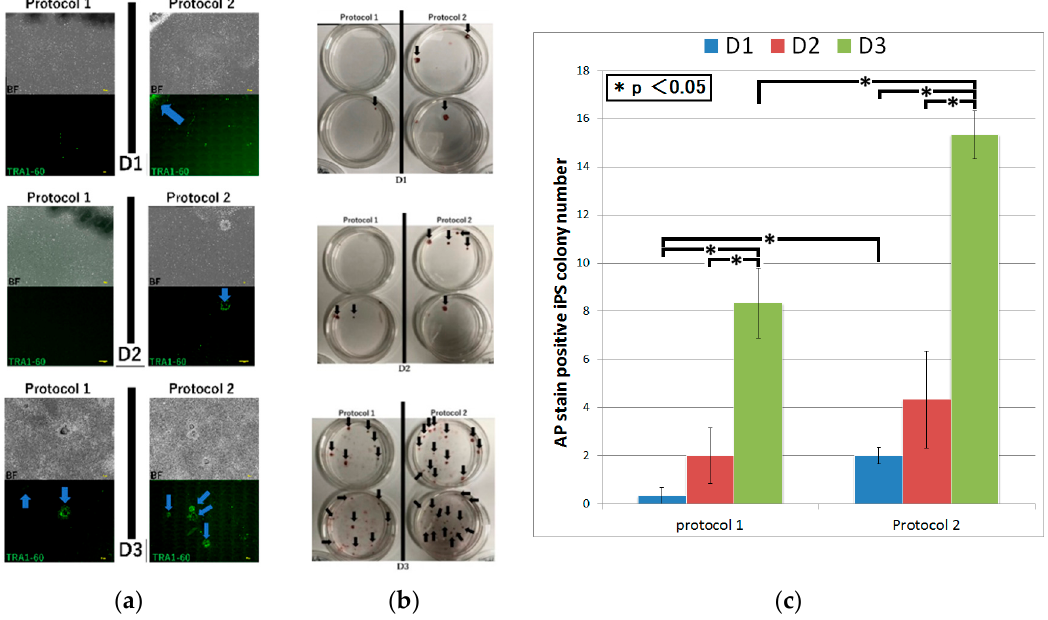
Figure 4. TRA-1-60 and alkaline phosphatase staining of iPS cell colonies induced from the dermal tissue of three elderly patients. ( a ) TRA-1 immunofluorescent staining of iPS cell colonies. Immunofluorescent staining with anti-TRA1-60 antibody was performed on D1 (top), D2 (middle), and D3 (bottom) cells subjected to protocol 1 (left) or protocol 2 (right) for iPS cell induction at day 35 post-transfection. An integration of 81 continuous fields of the view captured with the Keyence BZ-X710 microscope is shown (observed area: 23.915 mm × 17.936 mm). BF, bright field. Arrows indicate TRA1-60-positive iPS cell colonies. Scale bars: 3.0 mm. ( b ) Alkaline phosphatase staining of iPS cell colonies. Staining with alkaline phosphatase was performed on D1 (top), D2 (middle), and D3 (bottom) cells subjected to protocol 1 (left) or protocol 2 (right) for iPS cell induction at day 36 post-transfection. Arrows indicate alkaline phosphatase-positive iPS cell colonies. ( c ) The number of iPS cell colonies stained by alkaline phosphatase was quantitively analyzed in all fibroblasts. The left side is protocol 1 and the right side is protocol 2. Values shown are the mean ± SEM (* p < 0.05, n = 3). To further test the efficacy of our new protocol, we applied it to myocardial fibroblasts from all